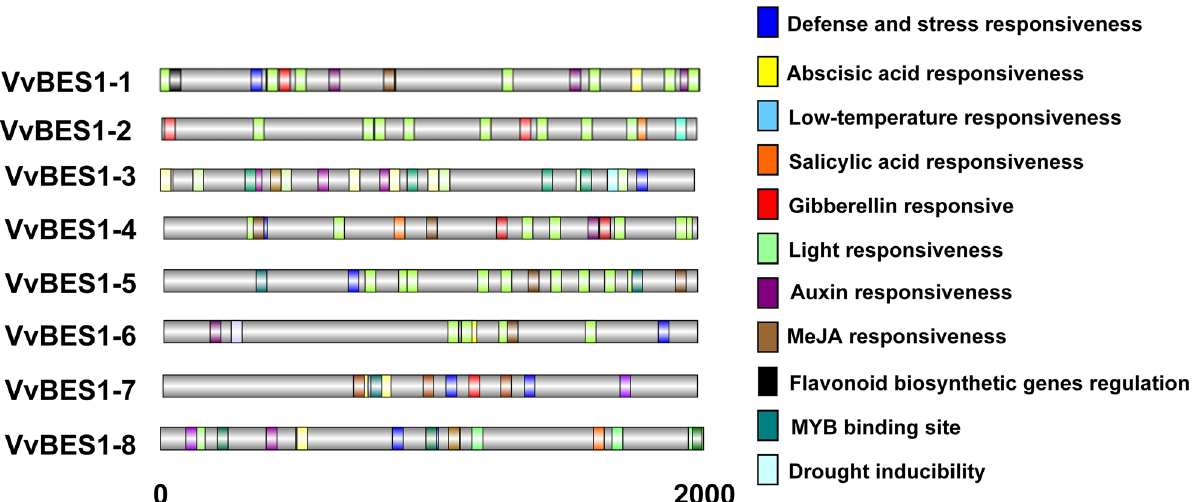
Figure 4. Analysis of Cis -acting elements associated with plant hormones responses and stress responses in the promoter region of VvBES1 genes. Cis -acting elements associated with plant hormones responsiveness and stress responsiveness are all shown by boxes with different